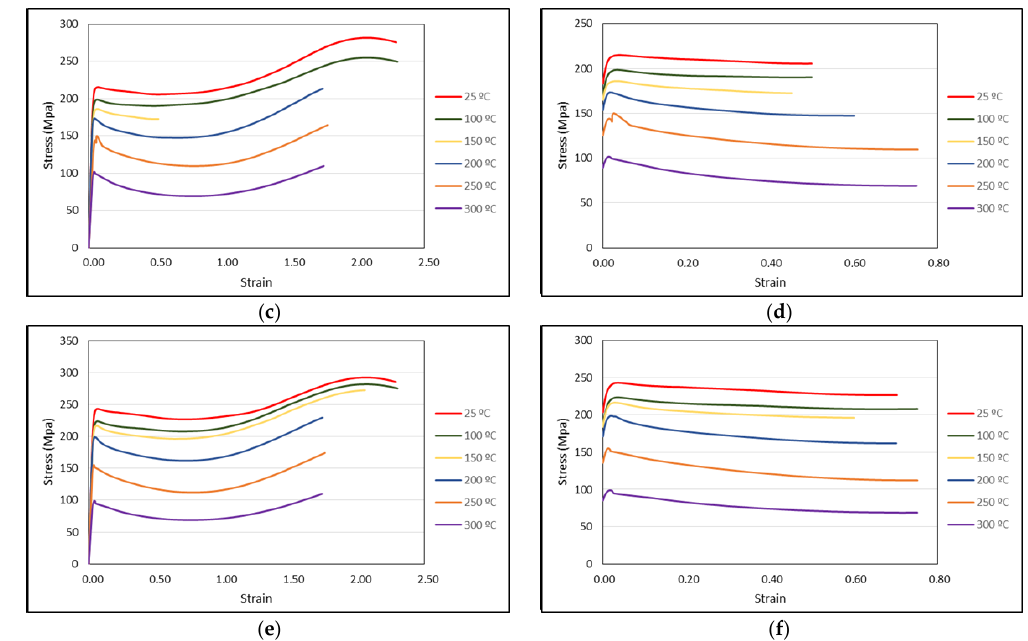
Figure 4. Complete flow rules experimentally obtained for AA3103 and their corresponding plastic zones selected for the development of the new flow rule: ( a ) complete flow curves for AA3103 at N0; ( b ) selected zone for AA3103 at N0; ( c ) complete flow curves for AA3103 at N2; ( d ) selected zone for AA3103 at N2; ( e ) complete flow curves for AA3103 at N4; ( f ) Selected zone for AA3103 at N4.